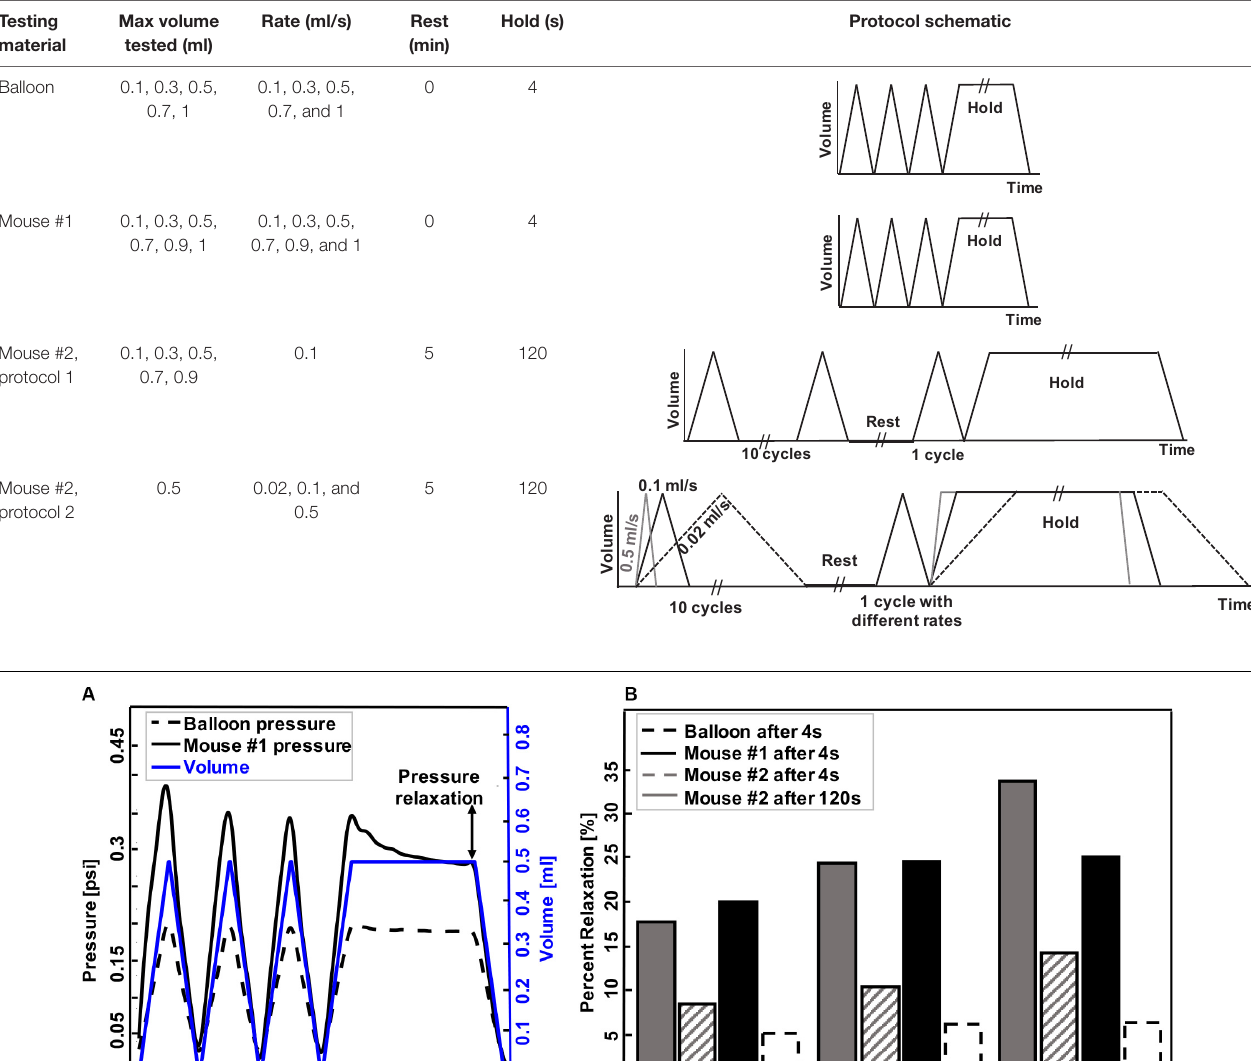
TABLE 1 | Experimental protocols used on various testing materials in this study.